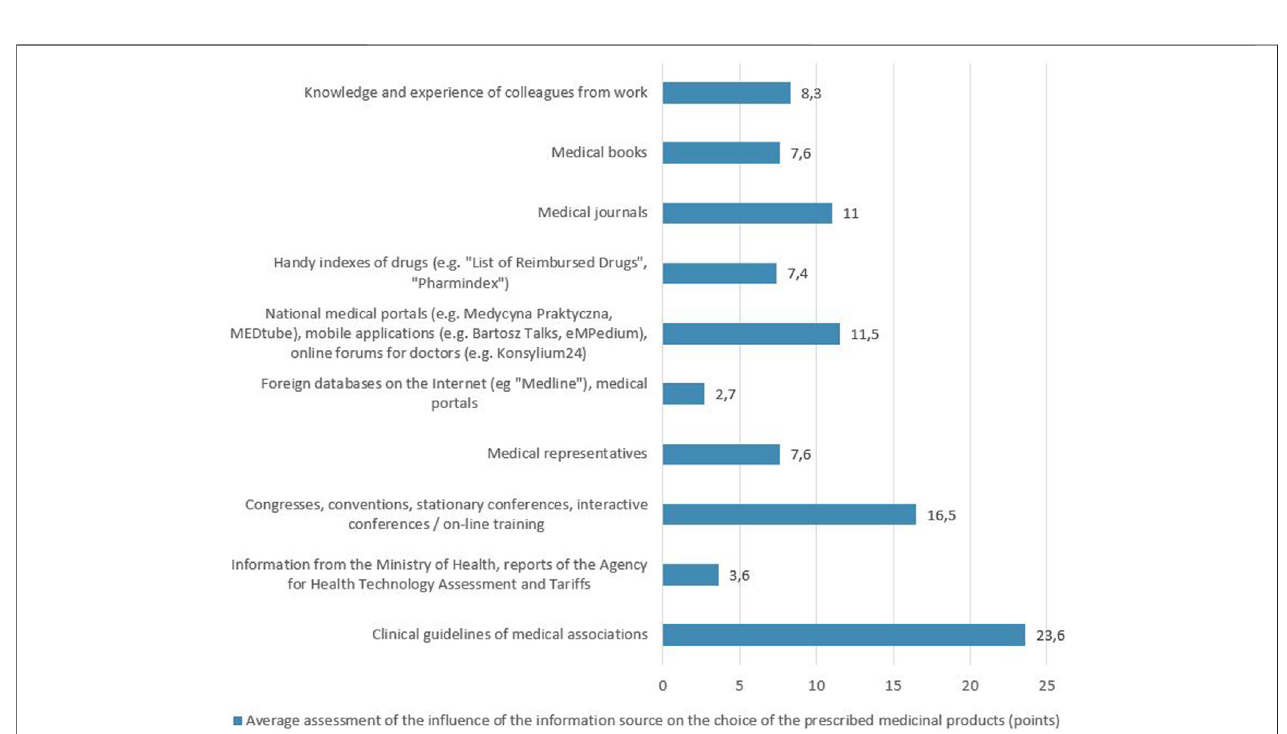
FIGURE 3 | Average assessment of the in fl uence of the information source on the choice of the prescribed medicinal products.